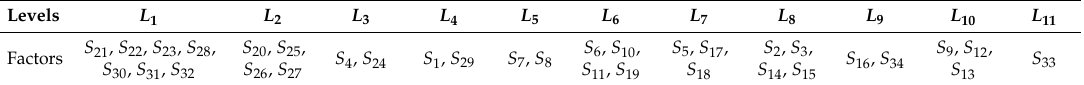
Table 7. Structural levels of all factors in the hierarchical